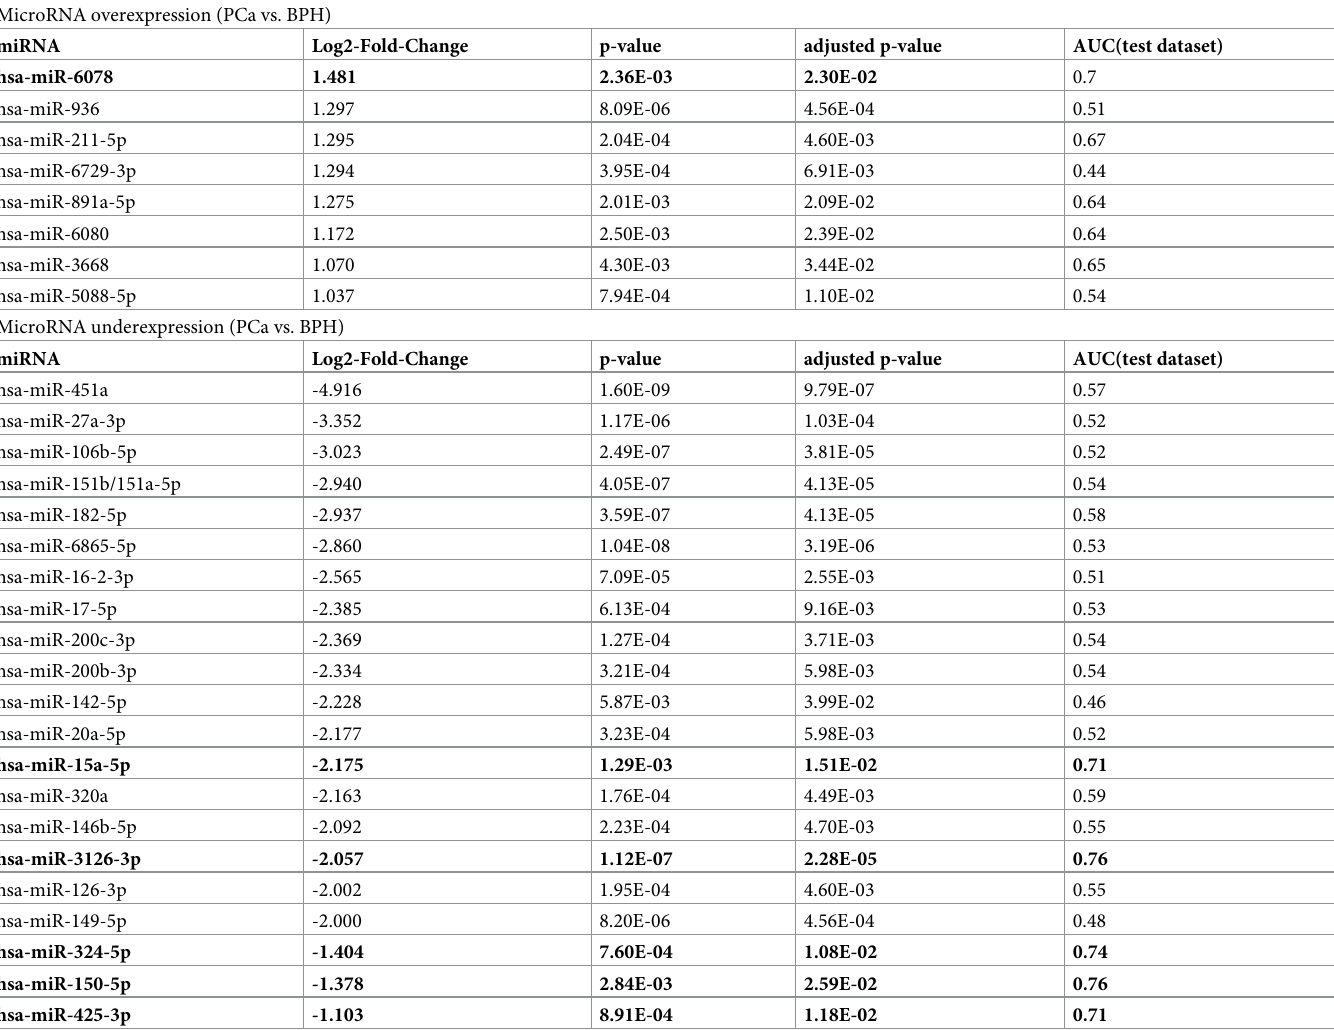
Table 3. Partial representation of differentially expressed miRNAs (complete data available as described). MicroRNA overexpression (PCa vs.